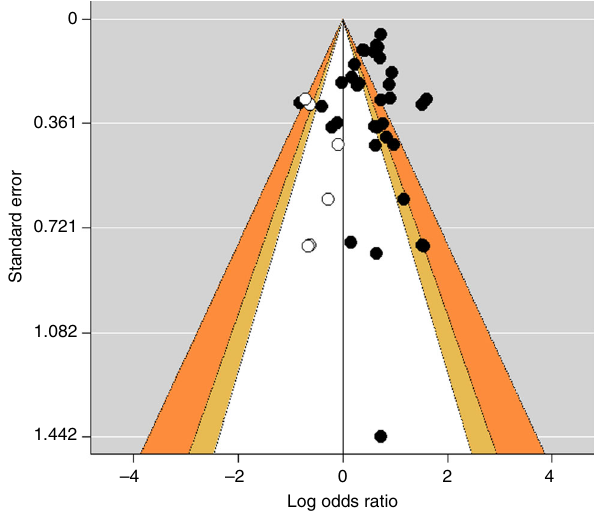
Fig. 3 Funnel plot for the regional meta-analysis. A plot of the logarithmic risk estimates vs. the precision (standard error) for each study, with adjustment using the trim and fi ll method. Closed circles denote identi fi ed studies and their summary measures, respectively. Open circles represent missing studies after adjustment for funnel plot asymmetry and the summary measure incorporating hypothetical studies, respectively. Key areas of statistical signi fi cance have been superimposed on the funnel, and the plot is now centred at zero. The yellow zones show effects between p = 0.10 and p = 0.05, and the orange zones show effects between p = 0.05 and p = 0.01. Effects in the white zone are greater than p = 0.10 and effects in the grey zones are smaller than p = 0.01. A Z -test was conducted to calculate p-